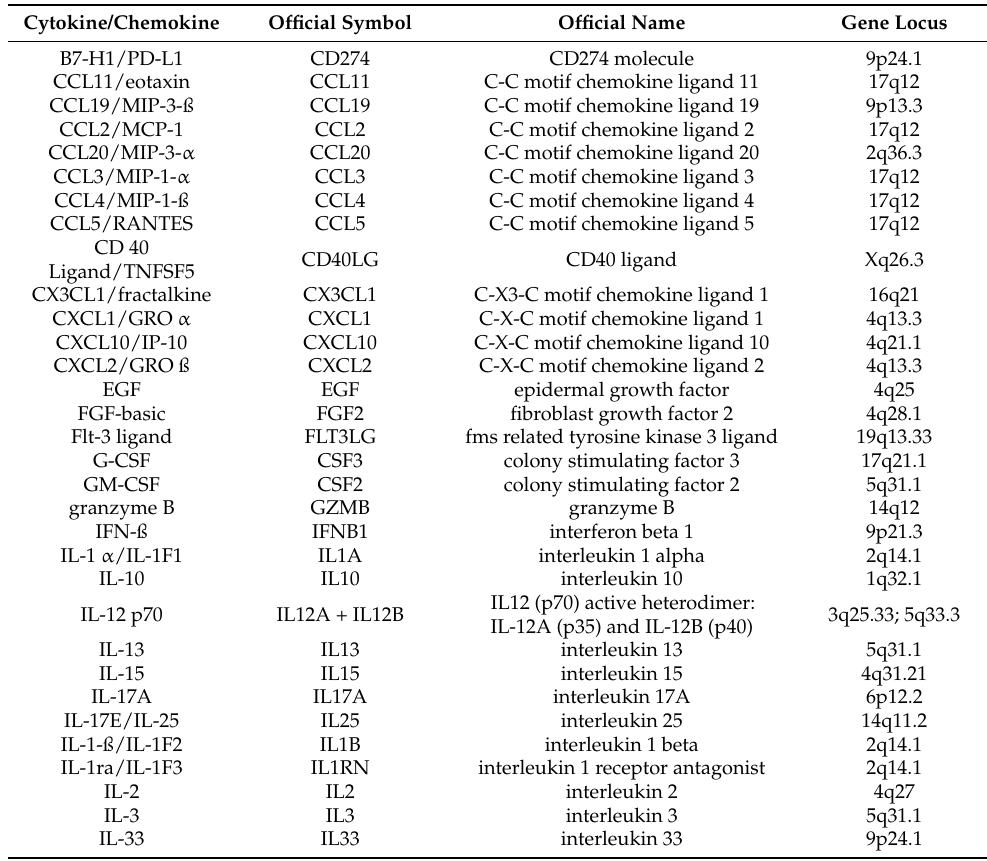
Table 2. The list of chemokines and cytokines